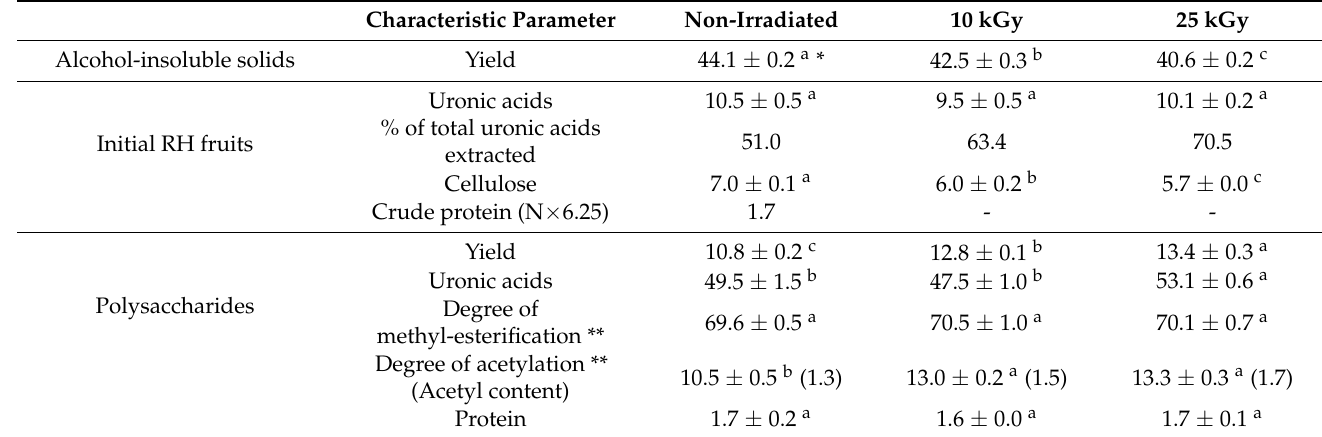
Table 4. Yield and chemical characteristics of alcohol-insoluble solids, initial RH fruits, and polysac- charides ( w / w